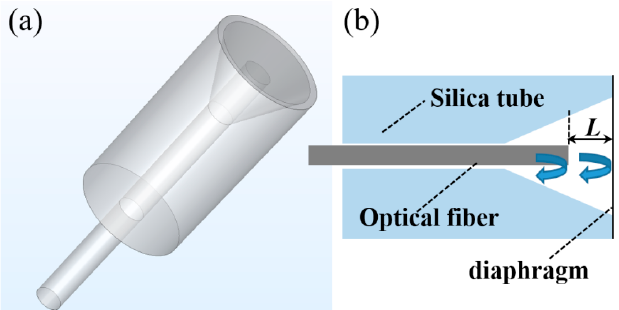
Figure 2. Schematic diagram of the proposed sensor: ( a ) side view of the Fabry–Perot cavity, and ( b ) model of the proposed sensor.